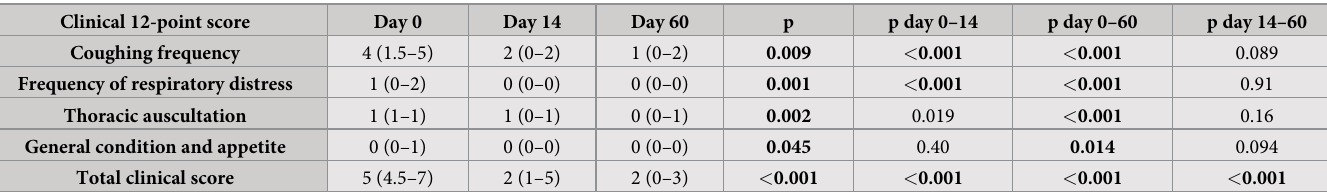
Table 4. Clinical 12-point score: Total clinical score and the individual criteria of the clinical 12-point score in cats with FLAD. Clinical 12-point score